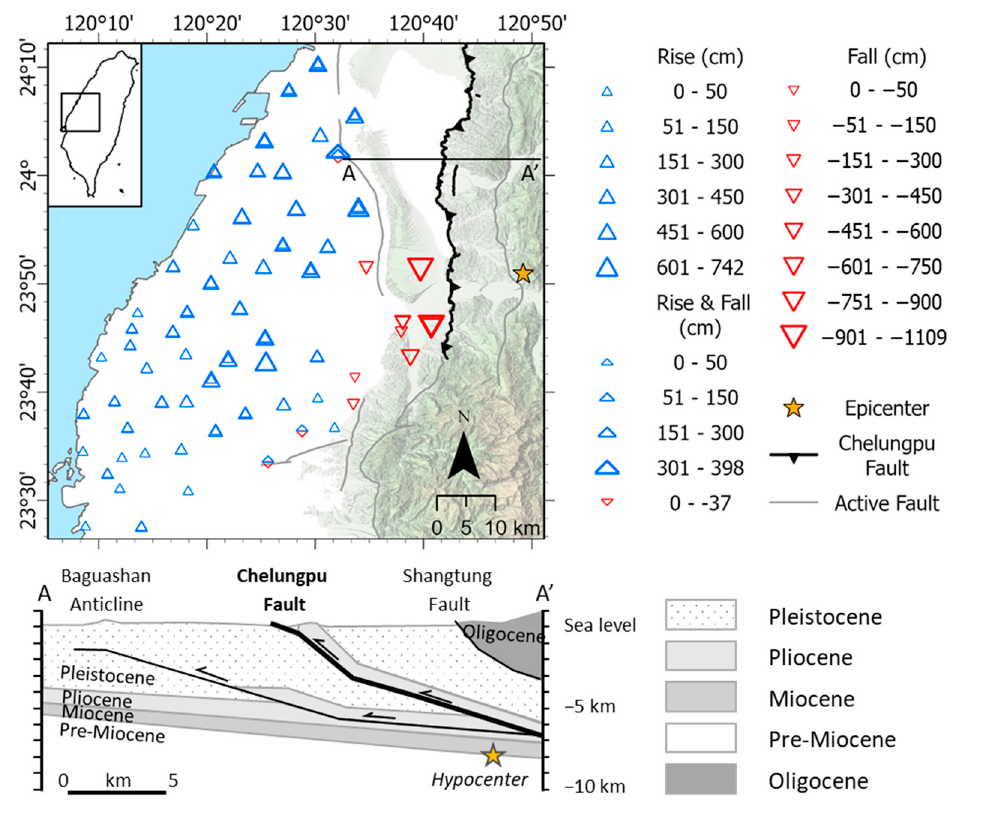
Figure 9. Distribution of coseismic groundwater level changes in the vicinity of a ruptured fault due to the 1999 M7.6 earthquake and the corresponding simplified geological cross-section of AA’ (adopted from [45,46]).